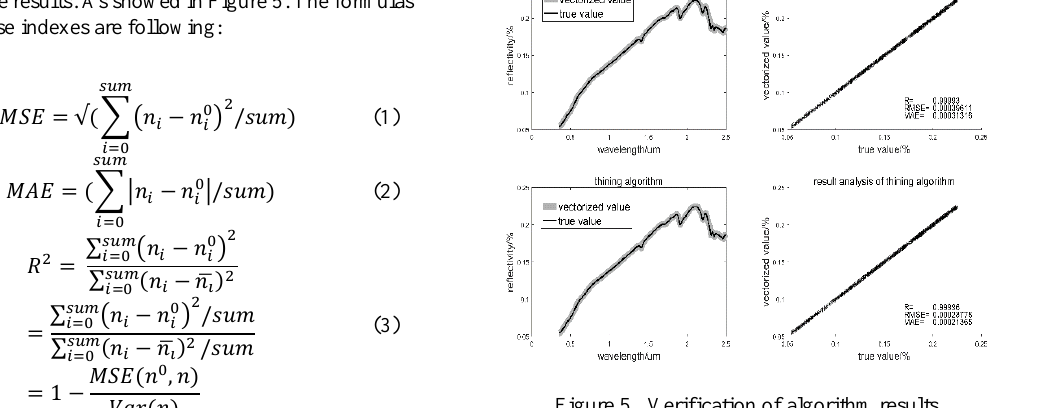
Figure 5. Verification of algorithm